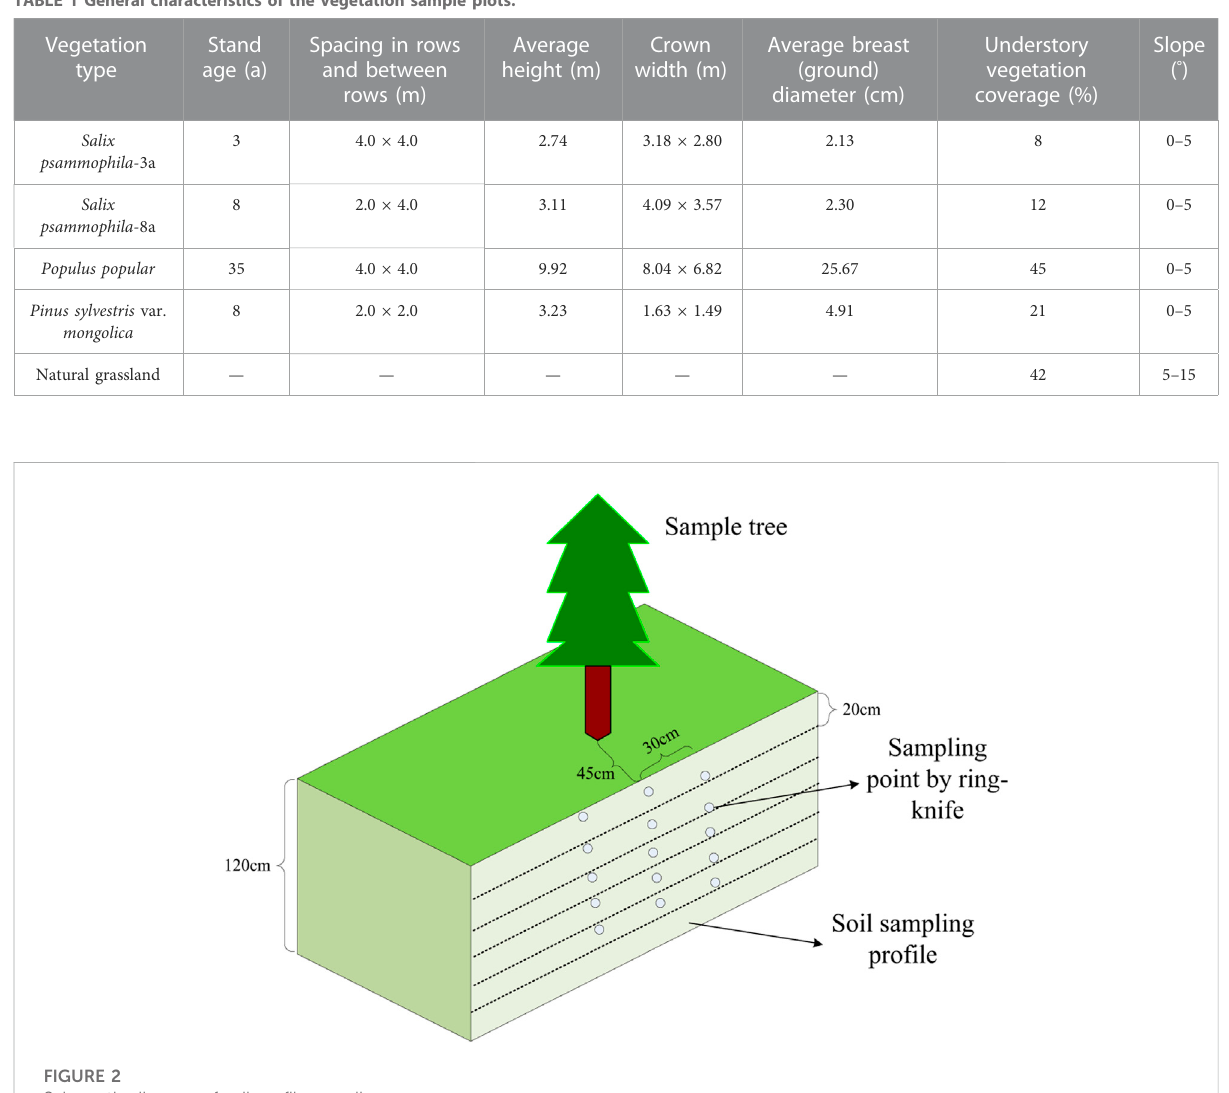
FIGURE 2 Schematic diagram of soil pro fi le